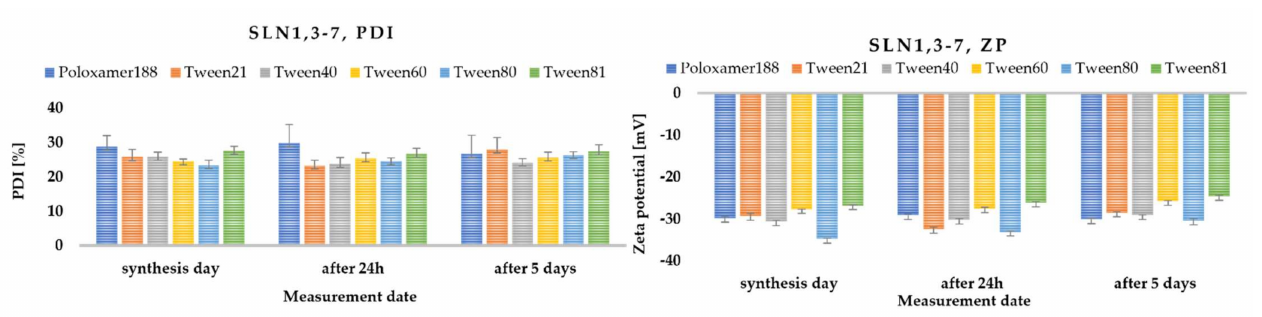
Figure 3. Comparison of polydispersity index (PDI) and zeta potential (ZP) of SLN synthesized with Softisan ® 601 lipid, and with all available surfactants (Poloxamer 188, Tween 21, Tween 40, Tween 60, Tween 80 and Tween 81), measured on the day of synthesis, and additionally 24 h and 5 days after synthesis. The process of obtaining nanoparticles was carried out in a closed-loop system under 300 bar pressure in three